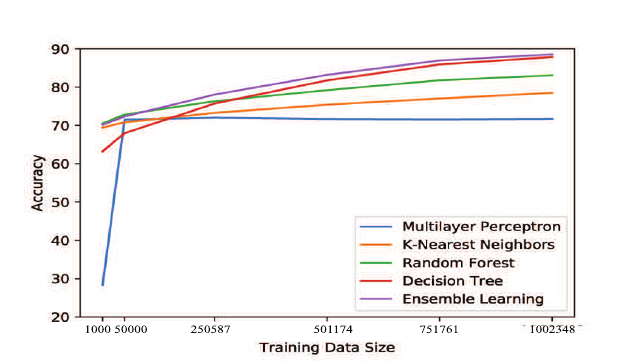
Figure 9. Performance evaluation of training data